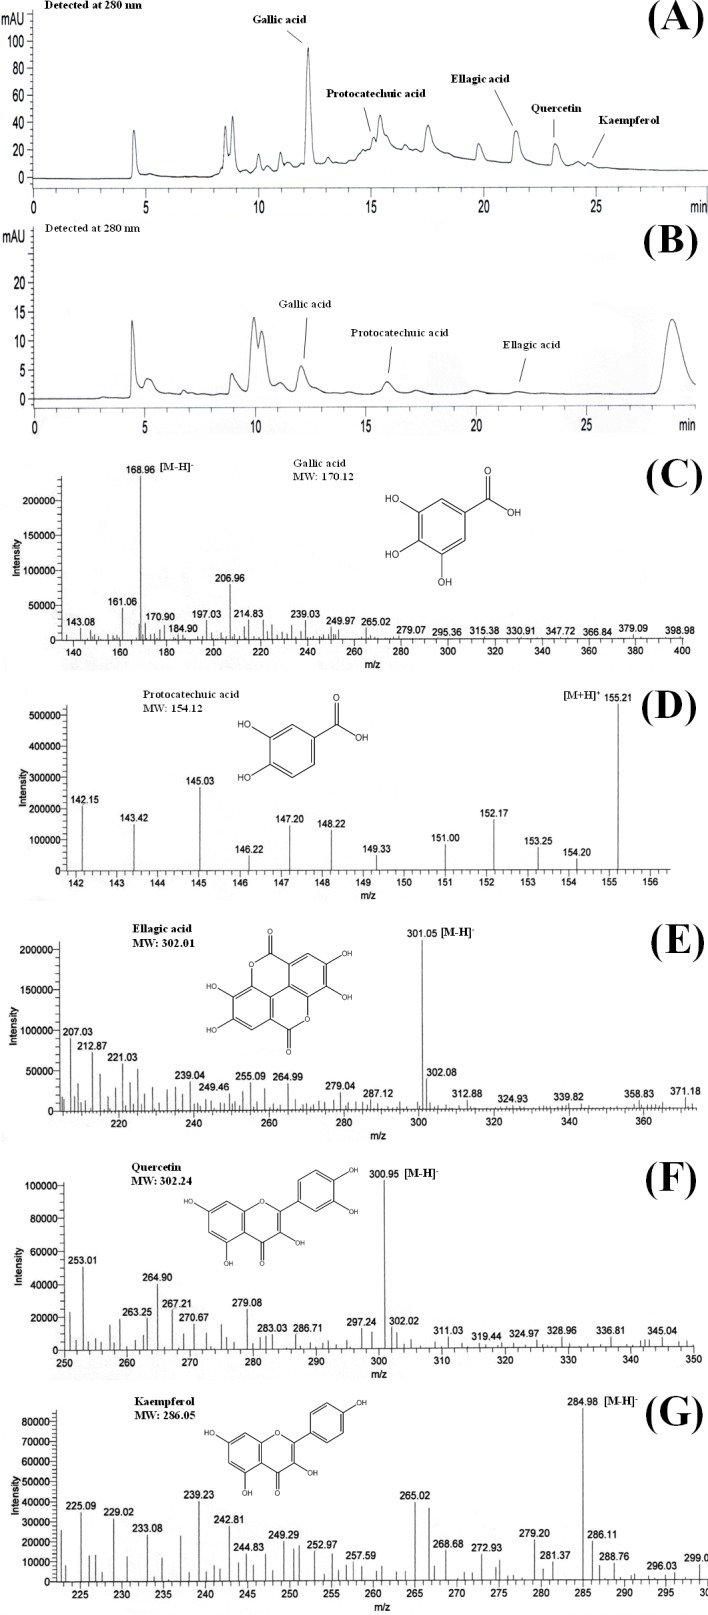
Chromatograms of (A) BLE and (B) BSE and the mass to charge ratio (m∕z) of (C) gallic acid, (D) protocatechuic acid, (E) ellagic acid, (F) quercetin and (G) kaempferol.The chromatograms were obtained from HPLC-DAD analyses while the m∕z was obtained from ESI-MS analyses. [M + H]+ and [M − H]− are the ions of the detected compounds obtained from the negative and positive full scan modes. BLE, Leaf water extract of B. racemosa; BSE, Stem water extract of B. racemosa.